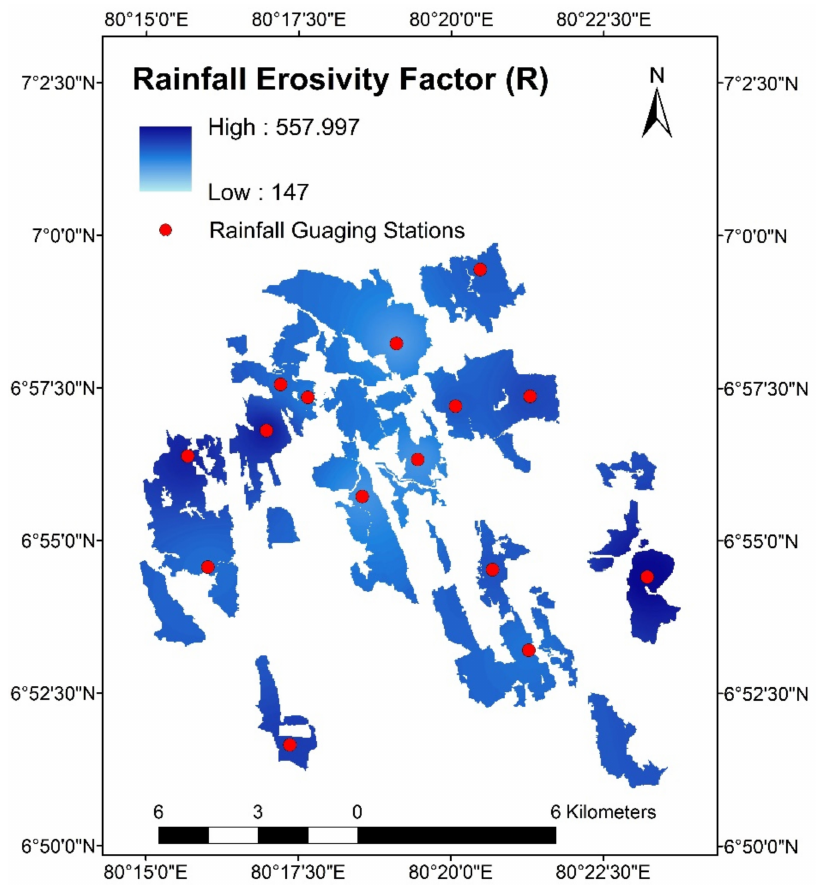
Figure 4. Map of the spatial distribution of the R factor with rainfall gauging stations of the study area.